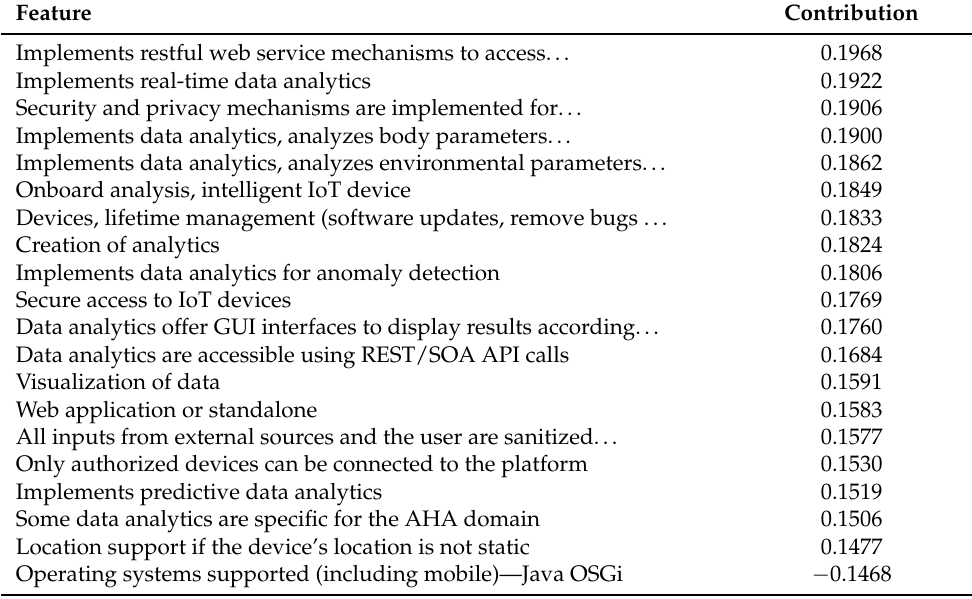
Table 2. Contributions of the top 20 features to the PCA1 component, ordered descending by abso- lute